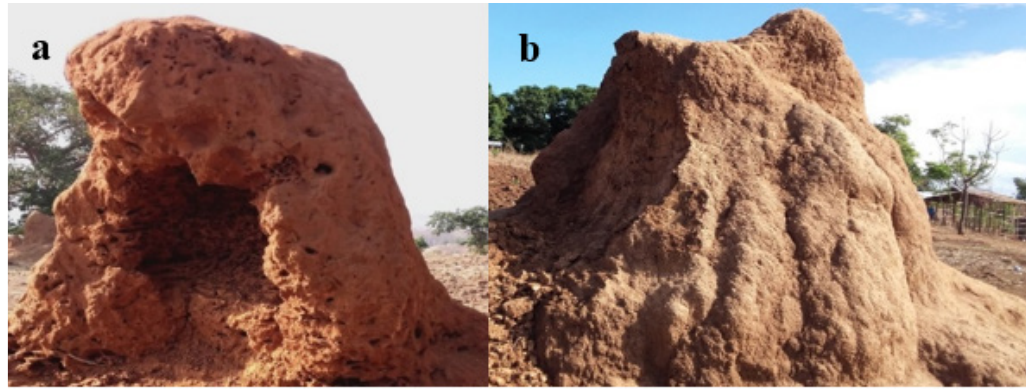
Figure 2: Colour of the termite mounds: ( a ) Jawaj (Red); ( b ) Sene